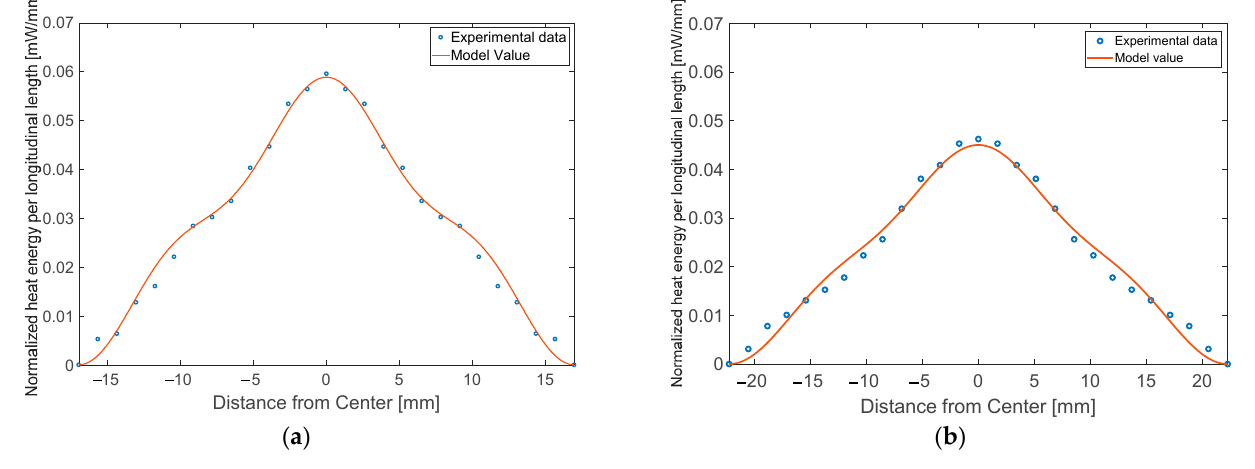
Figure 4. Calibration of the new model: ( a ) Focal length 20 mm ; ( b ) Focal length 40 mm. Table 1. Calibration of the model for the IR